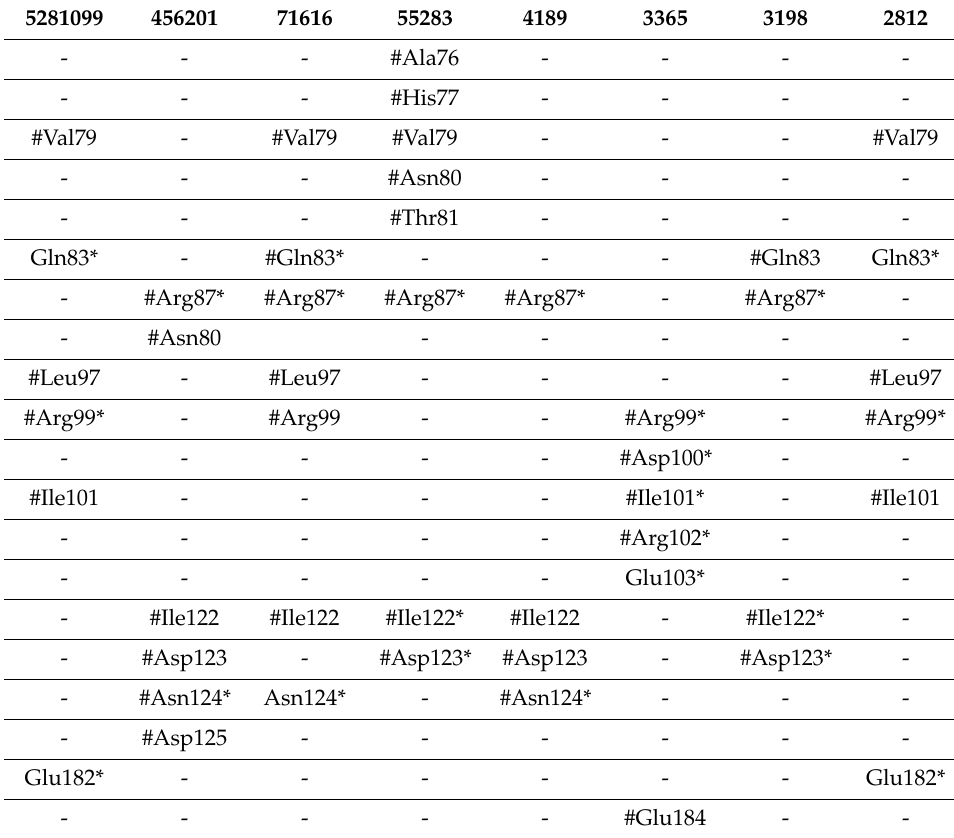
Table 3. Docking interactions of the anti-fungal agents within the binding pocket of the modeled RNAP from Aspergillus flavus